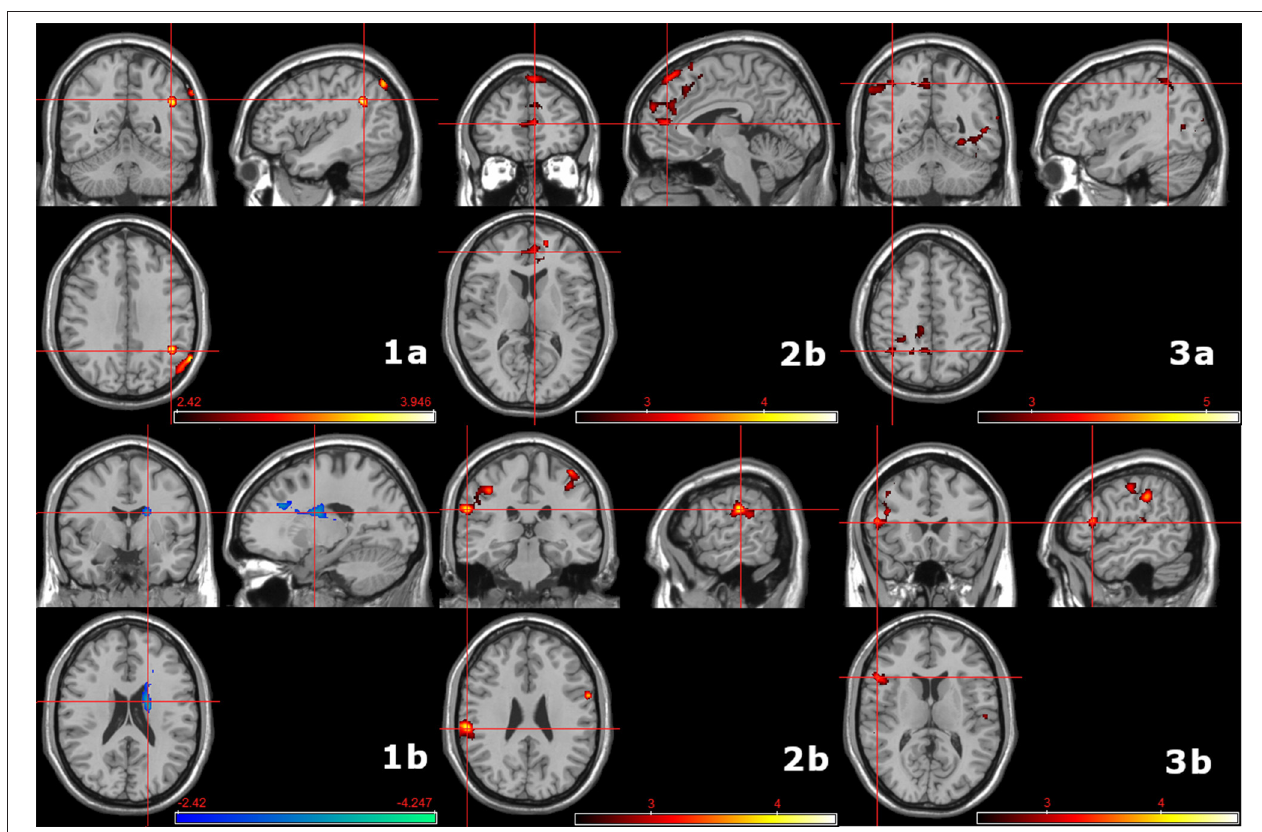
FIGURE 4 | Group comparisons (AUD, ADHD, HC) regarding differences in subcomponents of response inhibition. Left: Action withholding > interference inhibition; 1a: HC > ADHD (44, − 42, − 32); 1b: HC < AUD (18, − 2, 22). Middle: Action cancellation > interference inhibition; 2a: HC > ADHD ( − 24, 36, − 10); 2b: HC > AUD ( − 10, − 10, 16). Right: Action cancellation > action withholding; 3a: HC > ADHD (58, − 50, 24); 3b: HC > AUD (48, 0, 40). See also Supplementary Figure A.1. CDT of P < 0.01 ( k ≥ 460). The color bar indicates t-scores, with red to yellow indicating a positive contrast and blue to green a negative contrast,